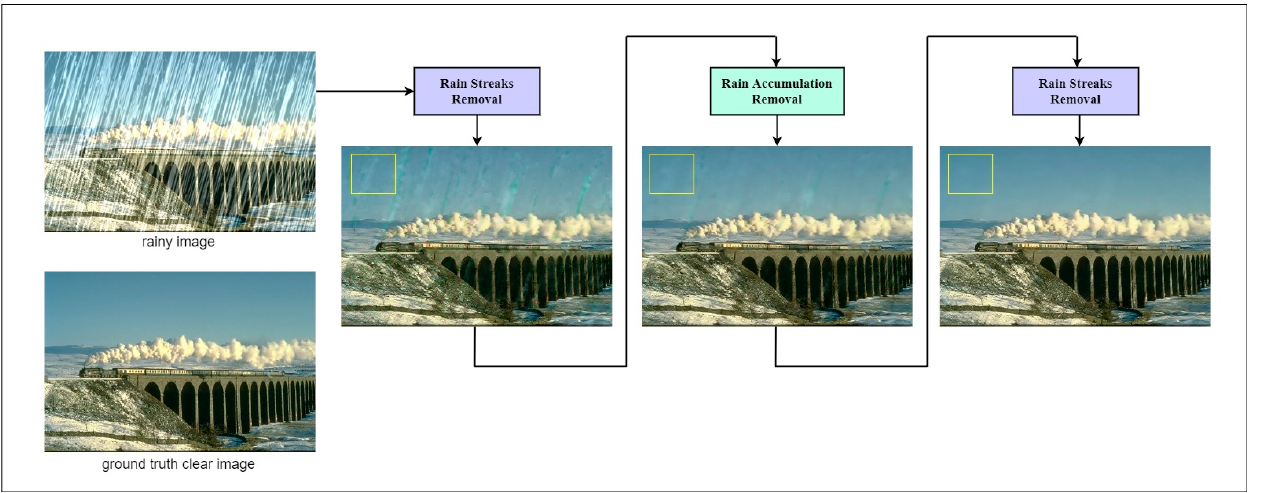
Figure 8. The effect of performing rain streak removal and rain accumulation removal progressively. Table 2. Effect of applying rain accumulation removal as pre-processing vs. applying it progressively.